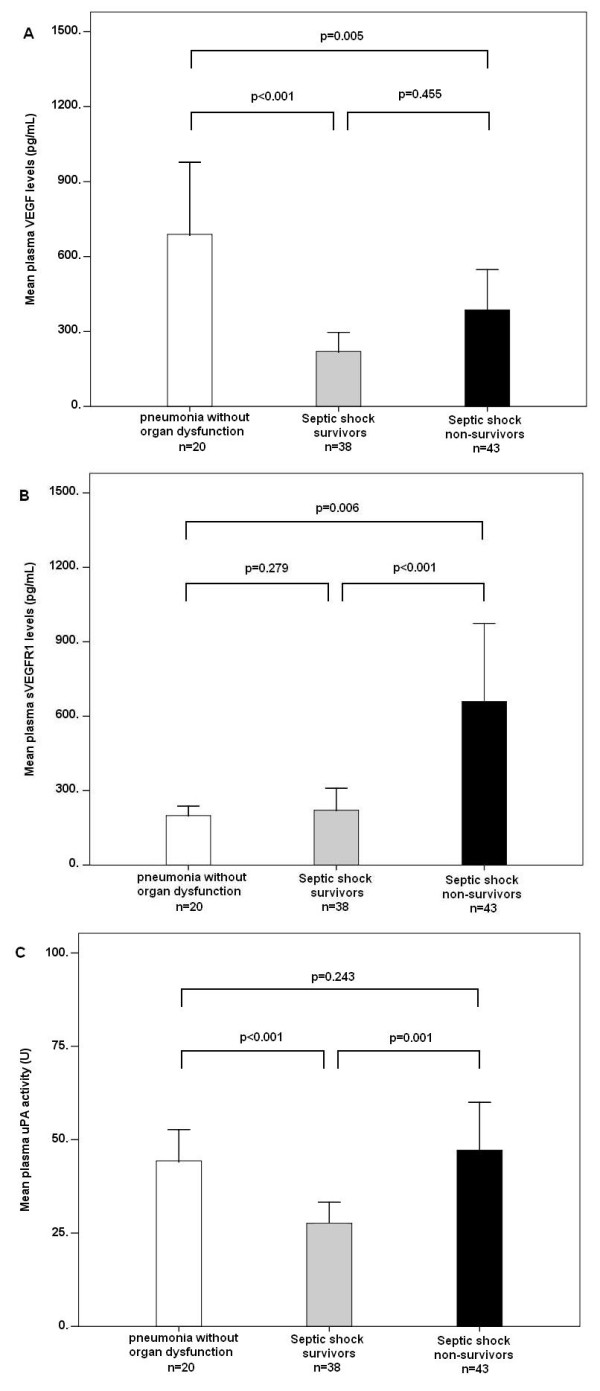
Mean plasma biomarker levels in patient subgroups. (a) Vascular endothelial growth factor (VEGF) and (b) soluble vascular endothelial growth factor receptor 1 (sVEGFR1) levels and (c) urokinase plasminogen activator (uPA) activity in patients with pneumonia without organ dysfunction (open bar), pneumonia-related septic shock survivors at day 28 (shaded bar), and non-survivors at day 28 (solid bar). Means and standard errors of the mean of plasma biomarker levels are shown. Significance was tested with the two-sided Mann-Whitney U test.